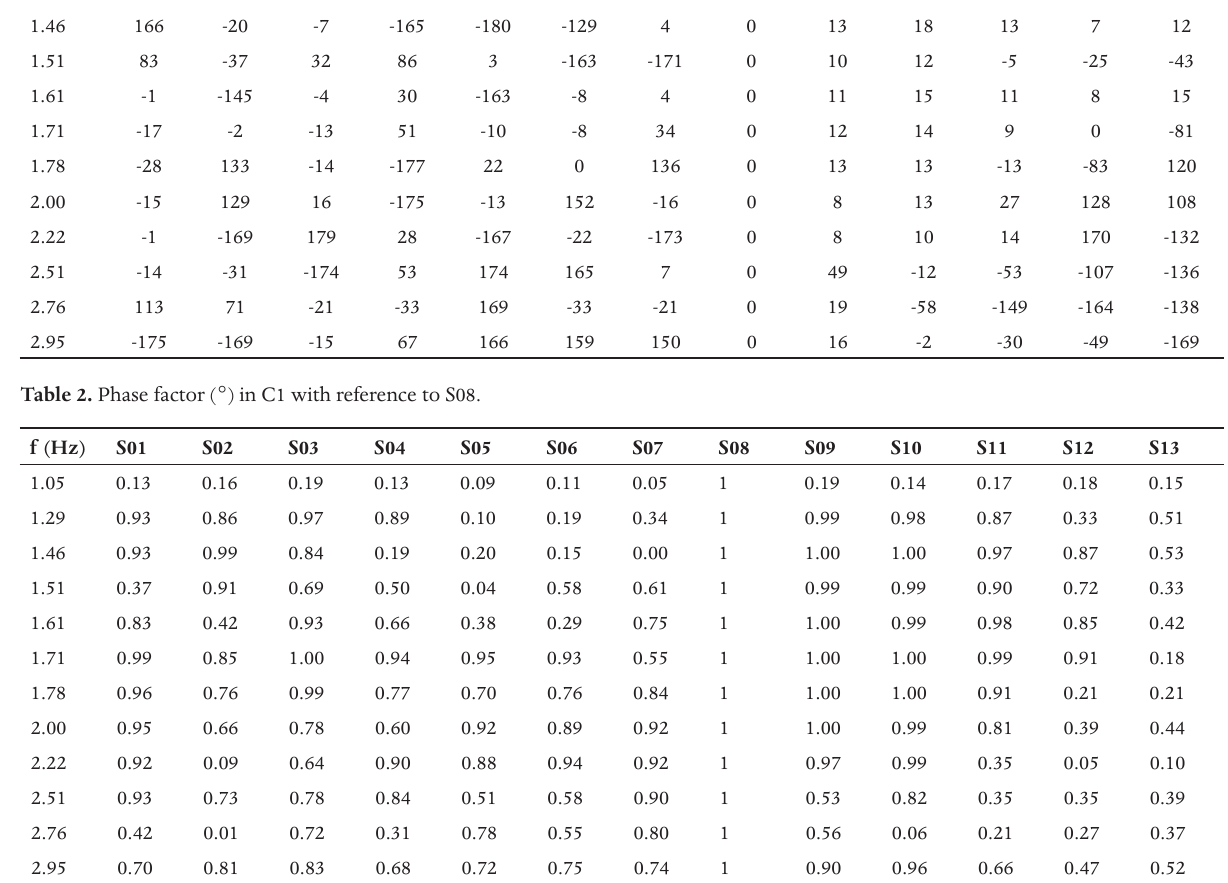
Table 3. Coherence function in C1 with reference to